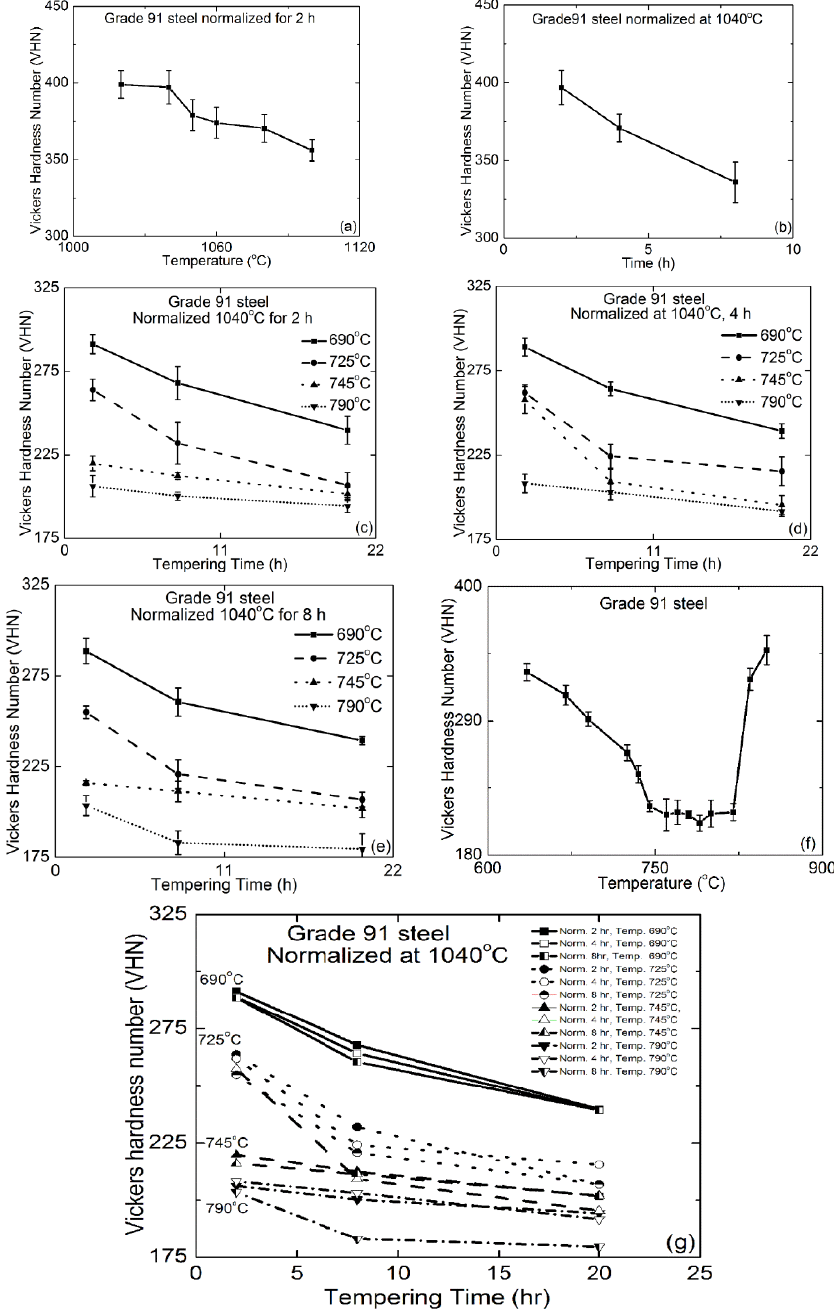
Figure 4. Variation in Vickers microhardness for various heat treatment